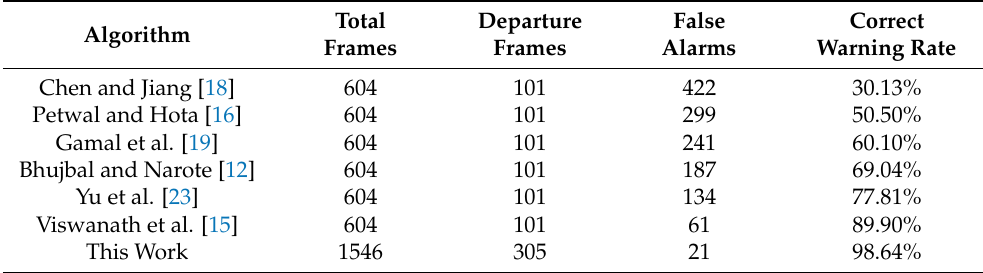
Table 2. Comparison of the proposed algorithm with state-of-the-art algorithms on lane departure